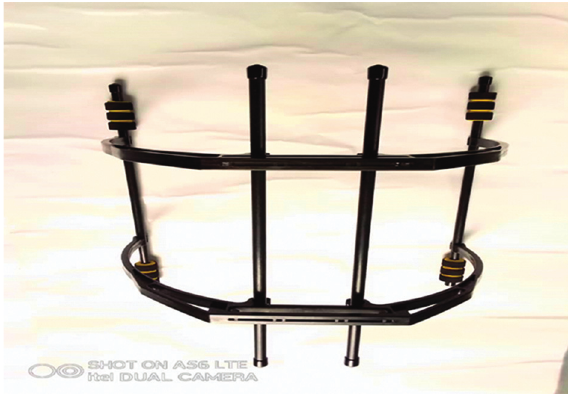
Figure 5: Landing gear. Table 1: UAV frame